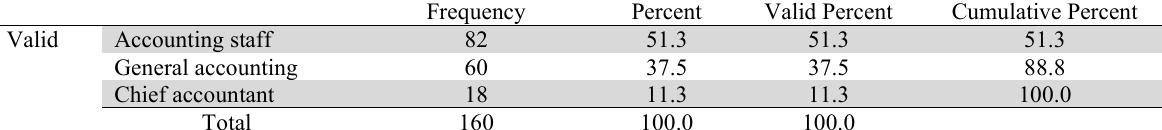
Frequency Percent Valid Percent